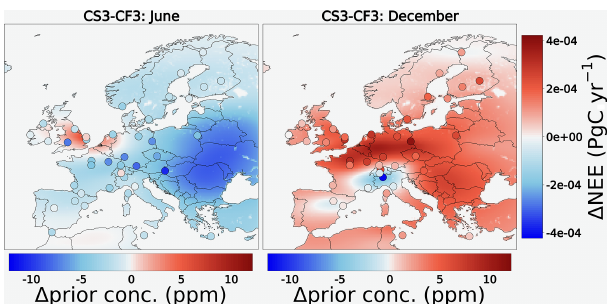
Figure 5. Spatial differences of posterior NEE estimated from the inversions CS3 and CF3 with STILT and FLEXPART transport models during June and December; filled circles indicate the dif- ferences in prior concentrations at the locations of sites (horizontal legend explains the magnitude of